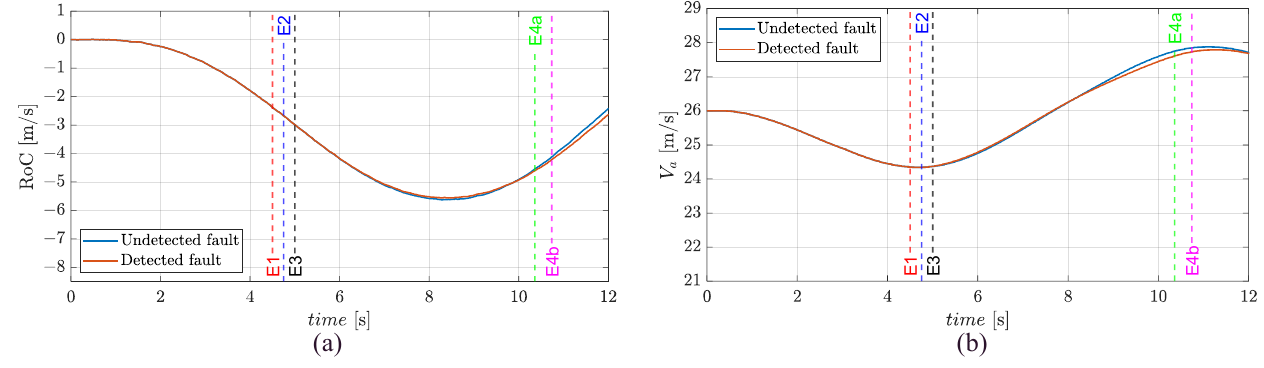
Figure 15. UAV response in flight termination/landing with phase-to-ground fault on stator 2 (E1, E2, E3 and E4 defined in Section 3.1): RoC ( a ), airspeed ( b ).